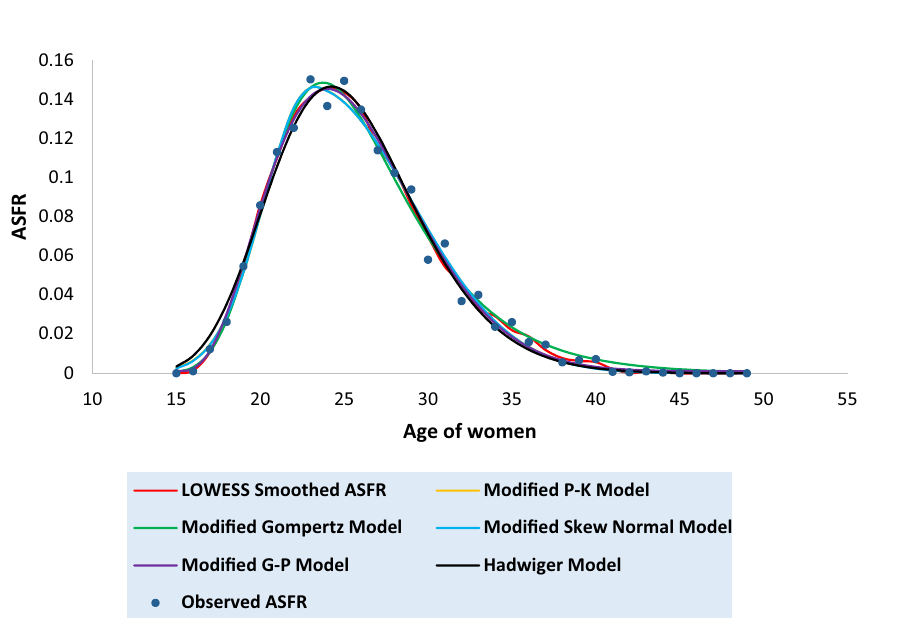
Figure 4. Observed and expected age-specific fertility rate (ASFR) for Punjab under different proposed models and Hadwiger